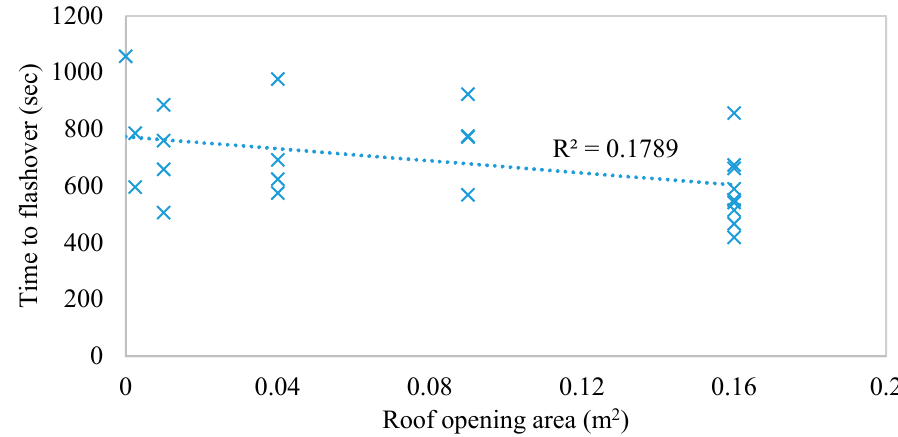
Figure 11. Time to flashover of compartments with different horizontal opening areas.